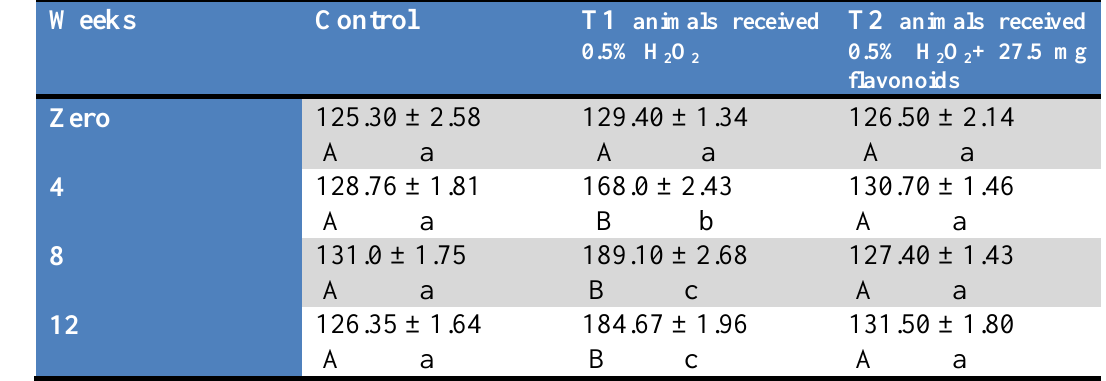
Table (10): Effect of flavonoids extracted from black cumin seeds for twelve weeks on serum triacylglycerol (TAG) concentration (mg/dl) in control and H male